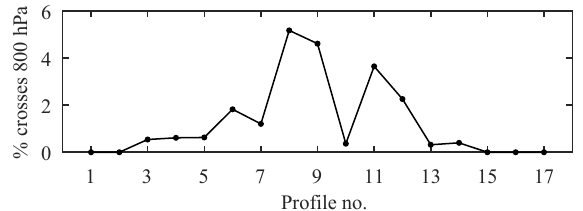
Figure 14. Percentage of back trajectories crossing the 800hPa sur- face within 1 day from the different ascent profiles on